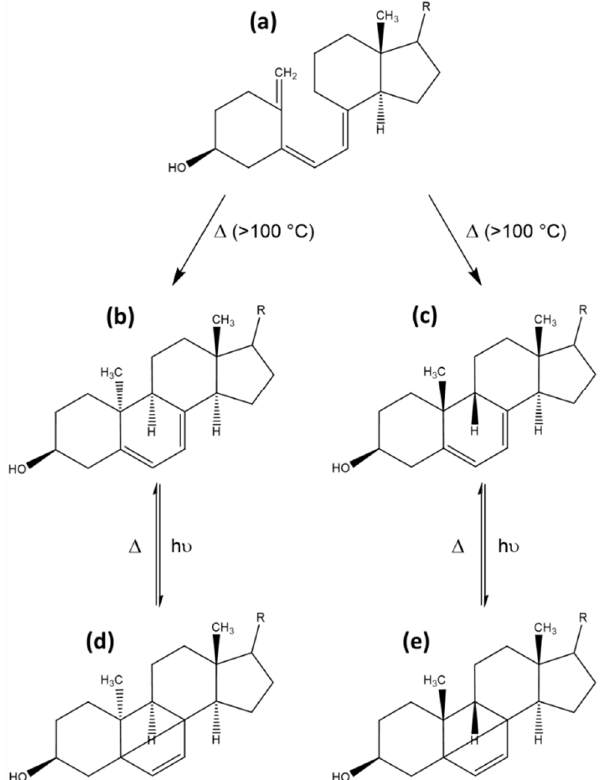
Figure 9. Synthesis pathway of pyrocalciferol and isopyrocalciferol and their respective photoproducts. Previtamin D ( a ) can undergo an irreversible ring-closure reaction at temperatures higher than 100 °C resulting in either a 9 α , 10 α confirmation (pyrocalciferol ( b )) or a 9 β , 10 β confirmation (isopyrocalciferol ( c )). Further UV irradiation results in the formation of the bicyclo [2,2,0] exene derivatives photopyrocalciferol ( d ) and photoisopyrocalciferol ( e ) in a reaction that can be reversed thermically.